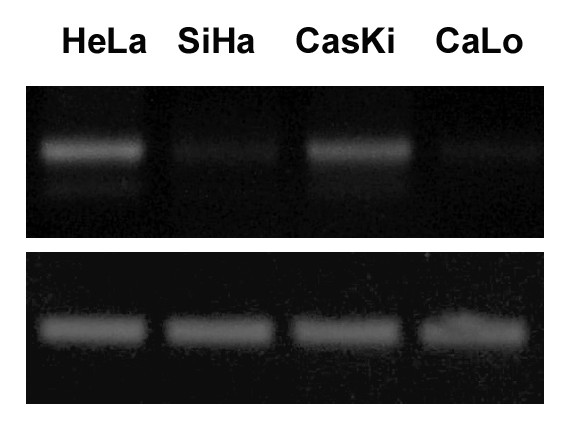
Smac/Diablo mRNA expression in cervical cancer cell lines. Upper panel: RT-PCR analysis of HeLa, SiHa, CasKi and CaLo cervical cancer cell lines. To the left molecular weight marker (100 bp ladder, Invitrogen). Lower panel: RT-PCR of GAPDH, used as a mRNA load control.